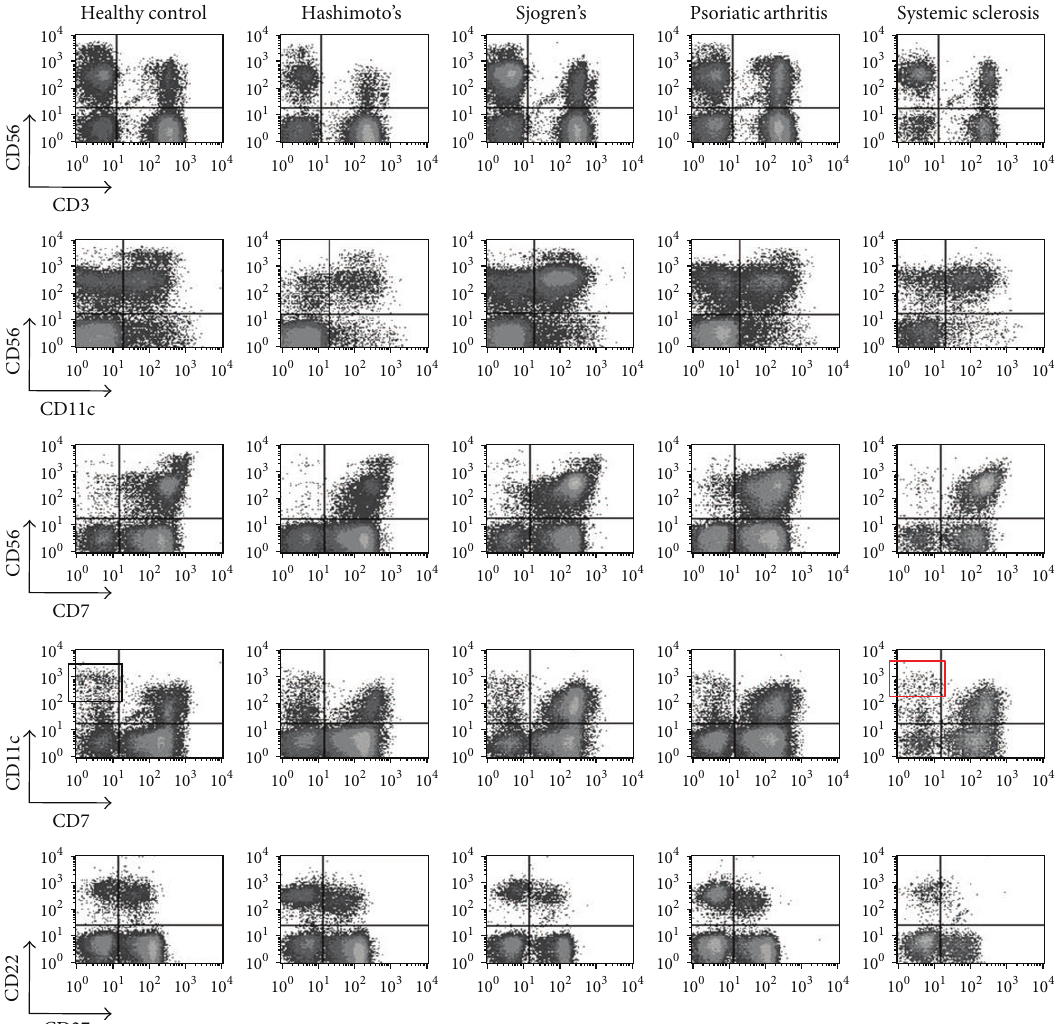
Figure 3: Surface epitope staining in methanol-permeabilized PBMCs of patients with autoimmune disorders. PBMCs from a representative healthy individual and patients with autoimmune disorders were fixed in 2% paraformaldehyde, permeabilized in methanol, and stained with MoAbs specific for CD3, CD56, CD7, CD11c, CD22, and CD27. Lymphocytes were gated on forward/side light scatter properties. Surface epitope staining was preserved in samples from healthy controls and autoimmune patients. The distinction of PBMCs subpopulations was